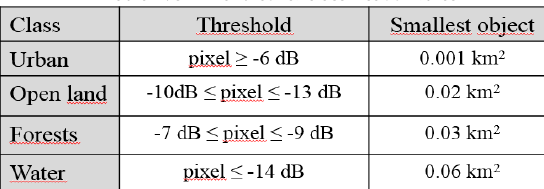
Table 1. SAR land cover classification rules